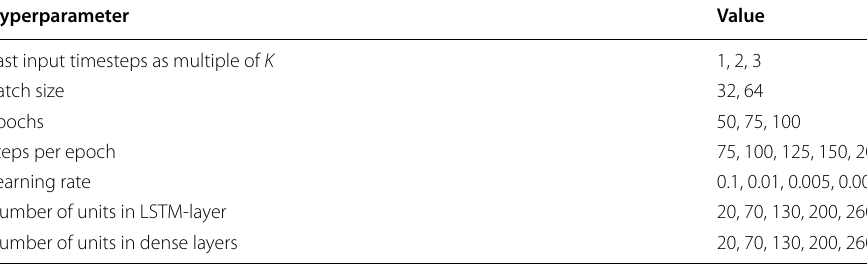
Table 1 In each run, a random combination of hyperparameters is tested Hyperparameter Value Past input timesteps as multiple of